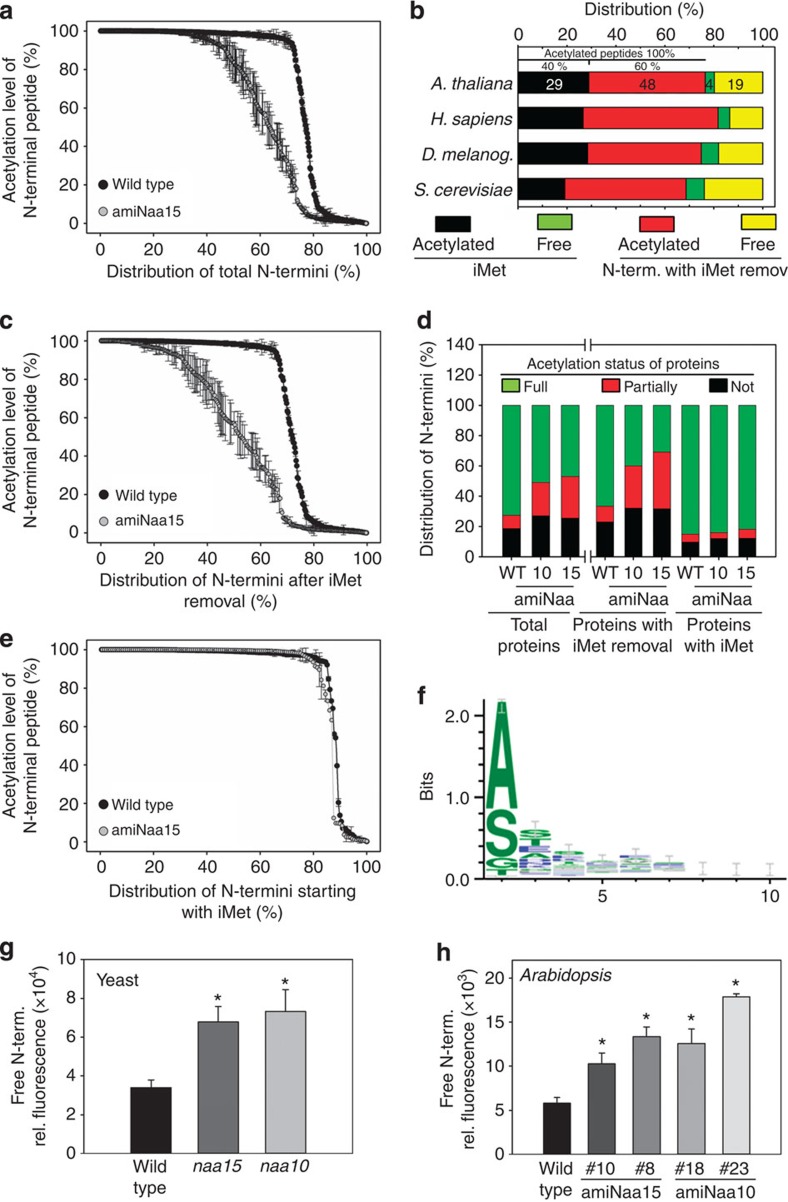
The plant NatA complex targets N termini after iMet removal.(a) Acetylation level of identified N-terminal peptides in leaves of 7-week-old wild-type (black) and amiNaa15 (grey) plants. (b) Amount of acetylated (black, red) and not acetylated N-terminal peptides (green, yellow) that were subject of iMet excision (red, yellow) or start with iMet (black, green) in Arabidopsis and other eukaryotes. (c,e) Acetylation level of N-terminal peptides from proteins that are subject to removal of iMet (c) or that are starting with iMet (e) in wild-type and amiNaa15 plants (subset of a). (d) Comparison of acetylation status for all proteins, proteins starting with iMet and proteins that were subject of iMet removal from wild-type and NatA-depleted plants. Proteins are designated as fully acetylated (green), when more than 90% of N-terminal peptides were found to be acetylated. Proteins of which 10% or less of N-terminal peptides were found acetylated are defined not acetylated (black). The remaining subset of proteins (20–80% acetylated N-terminal peptides) was defined partly acetylated. Soluble proteins were extracted from leaves of wild type, amiNaa10 line 23 and amiNaa15 line 8. After digestion of proteins, N-terminal peptides were enriched by SCX-approach for MS/MS analysis (N=4). (f) Weblogo of the experimentally characterized protein N termini that were subjected to iMet removal and highlighting differential NTA yield between WT versus amiNAA15 plant samples. (g) Quantification of free N termini in soluble protein extracts of the wild-type yeast and loss-of-NatA function mutants (naa15 and naa10) using NBD-Cl according to Supplementary Methods. (h) Quantification of free N termini in soluble protein fraction of 7-week-old-wild-type and NatA-depleted plants using the same method. Data are represented as mean±s.d. Asterisks indicate significant differences (P<0.05, N=3–4, Student's t-test).